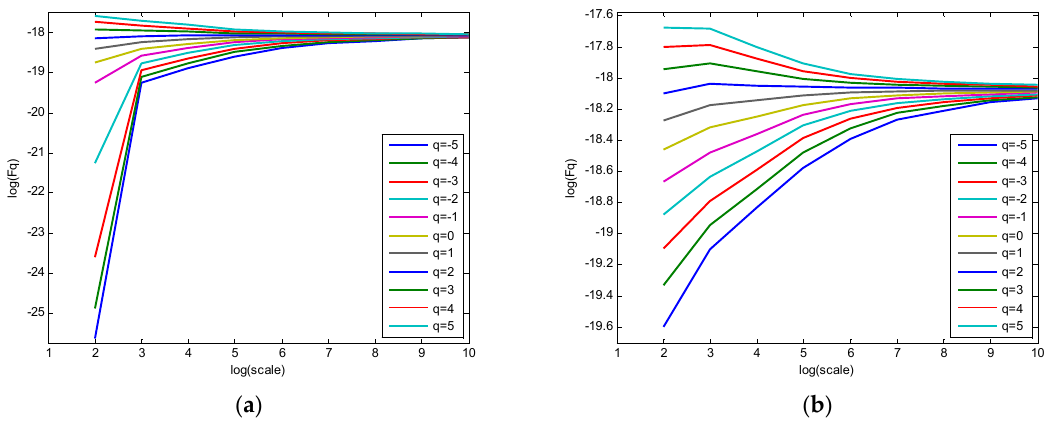
Figure 8. 𝑞 − 𝜏(𝑞) curves of three signal components obtained using: ( a ) the traditional MFDFA algorithm; and ( b ) the new MFDFA algorithm.